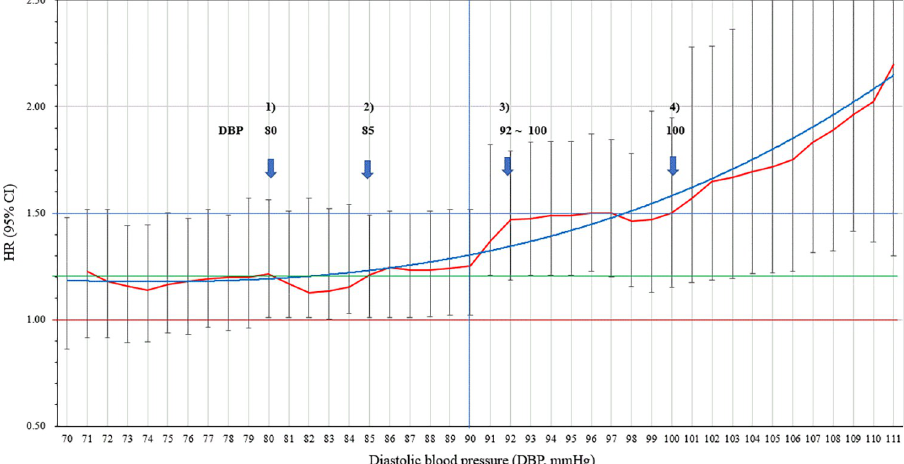
Fig 2. The risk trend of cardiovascular mortality according to each specific diastolic blood pressure (DBP) level.